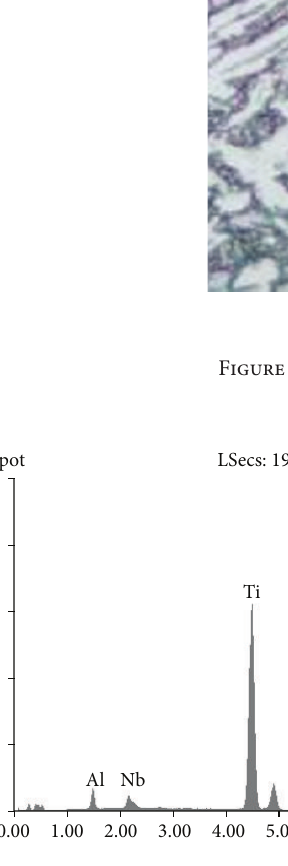
Figure 4: EDX spectrum of Ti-6Al-7Nb alloy.